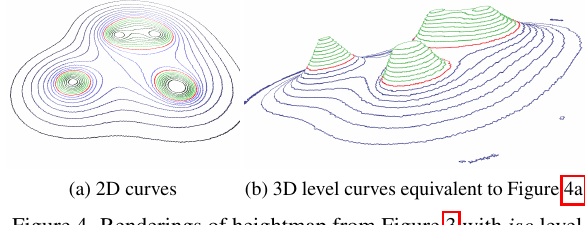
Figure 4. Renderings of heightmap from Figure 3 with iso level 120 and δ = 15 . Iso lines are red, lines above iso level are in shades of green, lines below in blue.